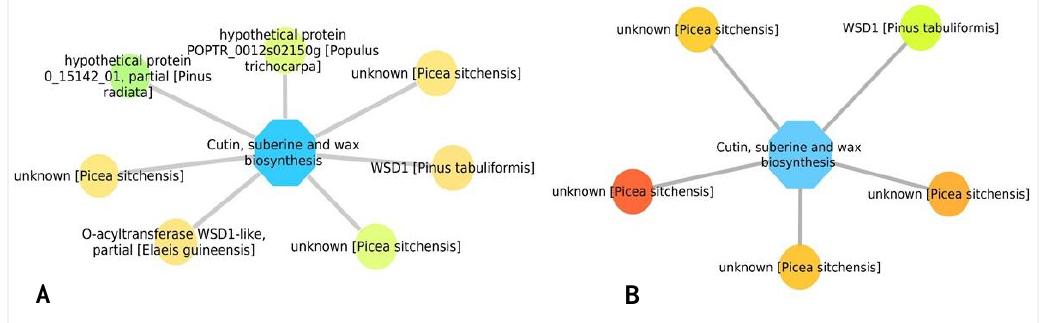
Figure 12. Cutin, suberin, and wax biosynthesis pathway with interactions assigned to DEG in Pinus pinaster ( A ) and in Pinus yunnanensis ( B ) at the second time point after inoculation (48 h). The blue node represents the pathway. The circular nodes represent DEG related to the pathway. Note that due to the complexity of representing the expression values of those genes in all the stages, the expression was colored on an RGB scale that goes from the most down-regulated in red to the most up-regulated in green.